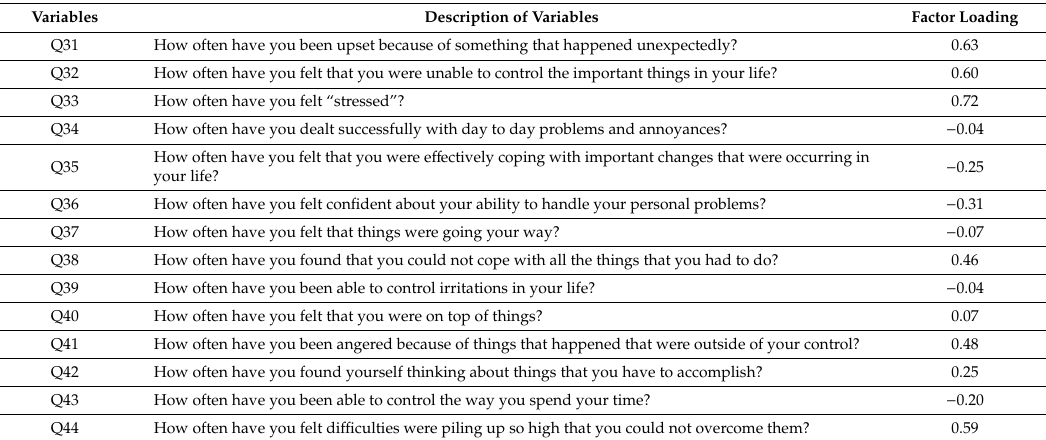
Table 9. Standardized direct e ff ects of STRESS.